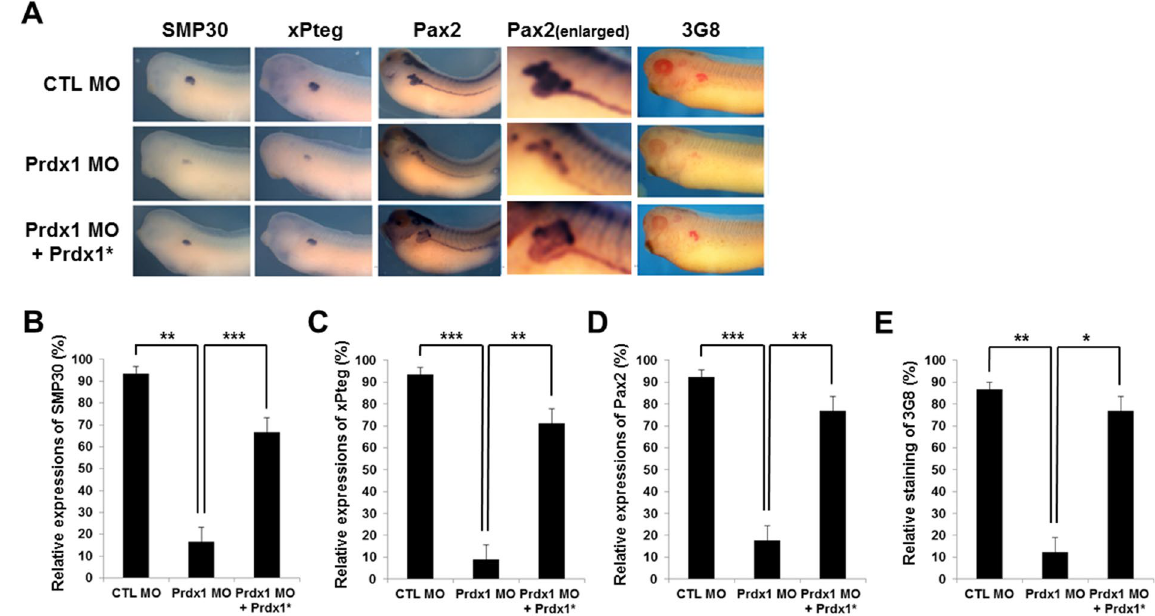
Figure 1. Inhibition of proximal tubule formation in the pronephros by the loss of Prdx1 and its rescue by Prdx1 * RNA co-injection. ( A ) prdx1 MOs (40 ng) were injected into both blastomeres of two-cell stage embryos. Embryos at the stage 33 were used for whole-mount in situ hybridization and immunohistochemistry. Proximal tubules in the pronephros were visualized by whole-mount in situ hybridization using smp30 , xPteg , and pax2 probes and by immunohistochemistry using a 3G8 antibody. Expression of the proximal tubule- specific markers smp30 ( B ), xPteg ( C ), and pax2 ( D ) in prdx1 MO-injected embryos compared with the controls. Co-injection with prdx1 * RNA rescued the decreased expression. The immunohistochemistry for 3G8 patterns were similar with whole-mount in situ hybridization ( E ). prdx1 morphants exihibited inhibition of proximal tubule formation only while intermediate, distal and connecting tubules were not affected by loss of prdx1